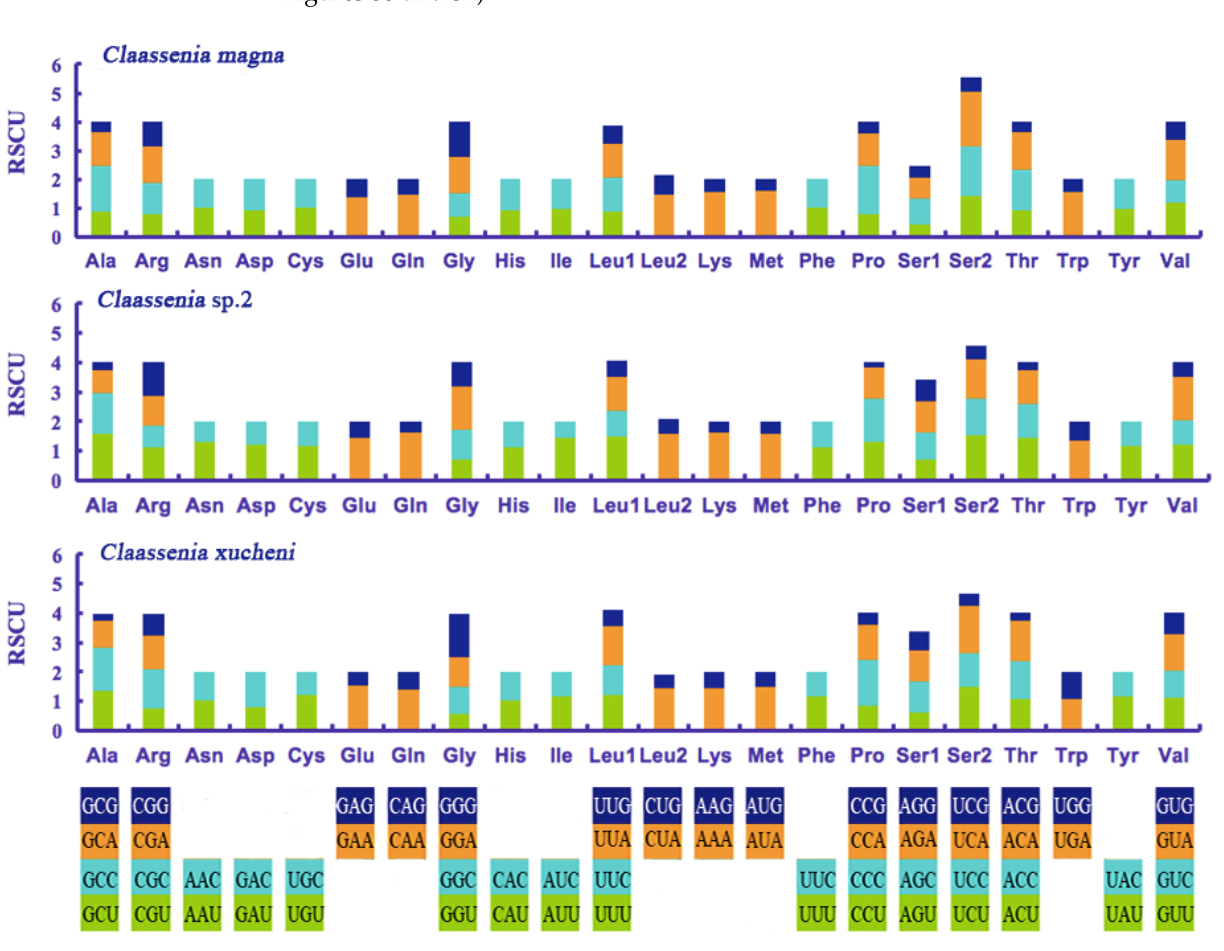
Figure 2. Relative synonymous codon usage (RSCU) in mitogenomes of the three Claassenia species.